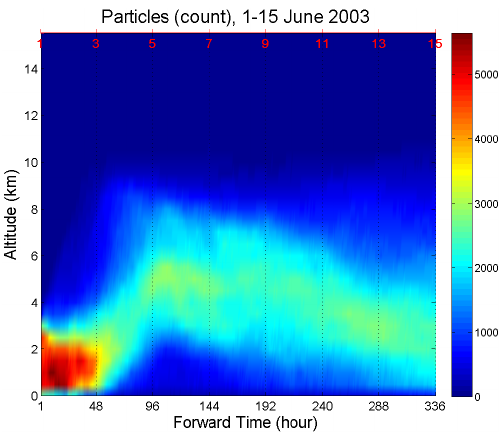
Figure 8. Vertical distribution of particles, varying with time from 1 June 2003 at 00:00 UTC to 15 June 2003 at 00:00 UTC. The particles were released from fire regions in Fig. 7b from the surface to 3km on 1 June 2003 and forward trajectories were calculated (14 days). The forward time (in h) and date (in June) are indicated in the x axis on the bottom and the top,